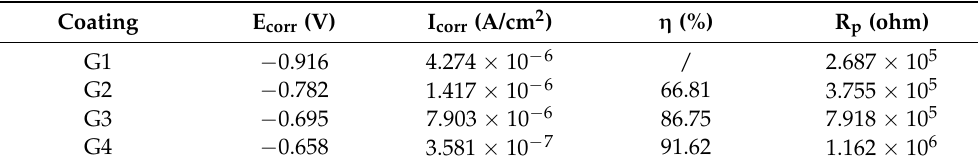
Table 8. Kinetic parameters of each coating in seawater of 40% concentration for 90 days.